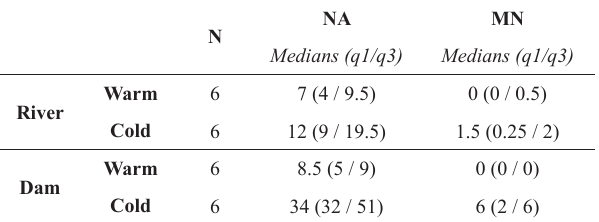
Fig. 3. Piscine micronucleus test, (2000 peripheral red blood cells per fish) in Astyanax jacuhiensis from river (gray boxes) and dam (white boxes) sampled in warm and cold season from Uruguai basin. N = 6. Different letters represent significant differences between seasons of the same environment (river or dam). Asterisks represent significant differences between environments in the same season. Table 4. Frequency of micronucleus and nuclear alterations in erythrocytes of Astyanax jachuiensis samples from two environments of the rio Uruguay basin, in warm and cold